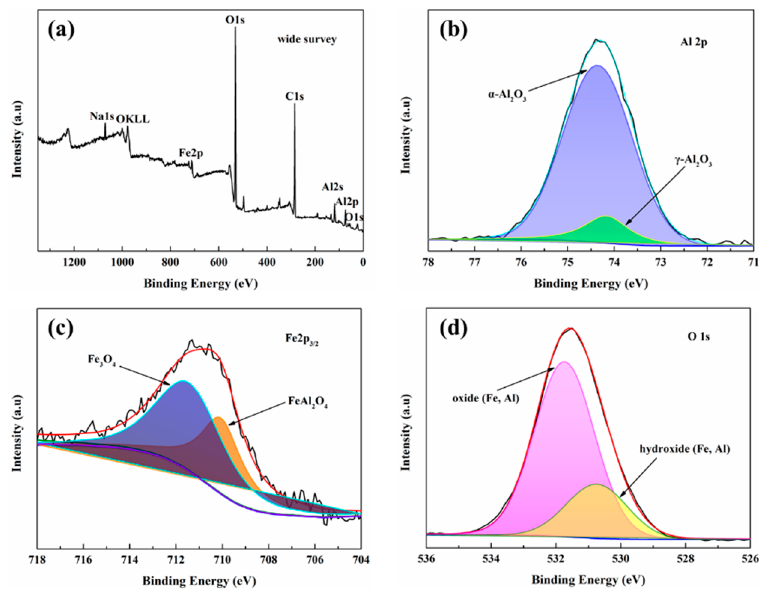
Figure 4. XPS spectra of the sample F3 coating: ( a ) Wide survey; ( b ) Al 2p; ( c ) Fe 2p 3/2 ; ( d ) O 1s. Table 4. Quantitative analysis of the sample F3 coating.